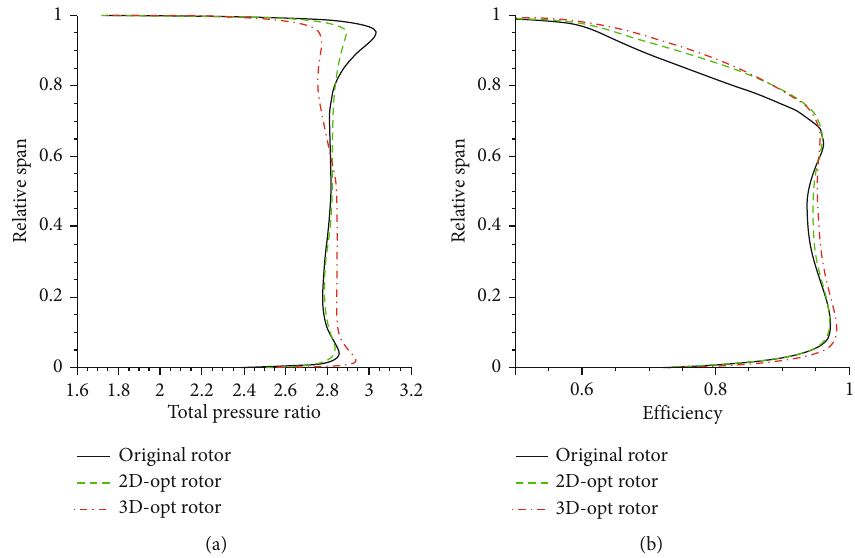
Figure 9: Radial distribution of average outlet tangential parameters at the design